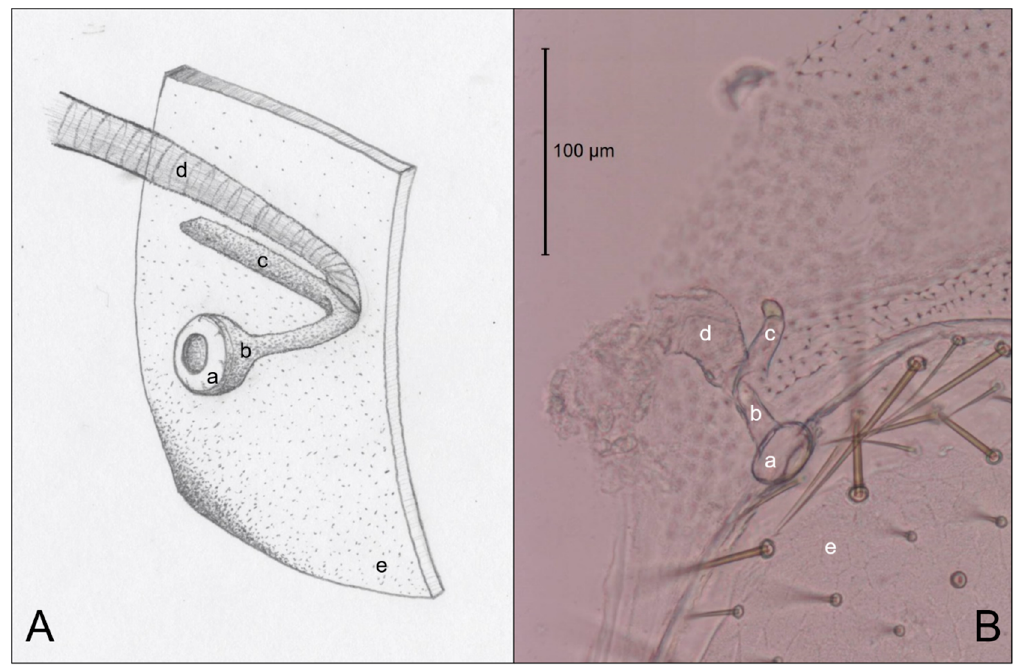
Figure 5. Comparison of an artist’s interpretation and photograph of the attachment of the spiracle structure and the trachea of Co. formosanus . ( A ) Drawing of spiracle-tracheal attachment; ( B ) Photograph illustrating spiracle-tracheal attachment. a : spiracle cap (peritreme); b : atrium; c : atrial arm of spiracle structure; d : tracheal trunk; e : cuticle.